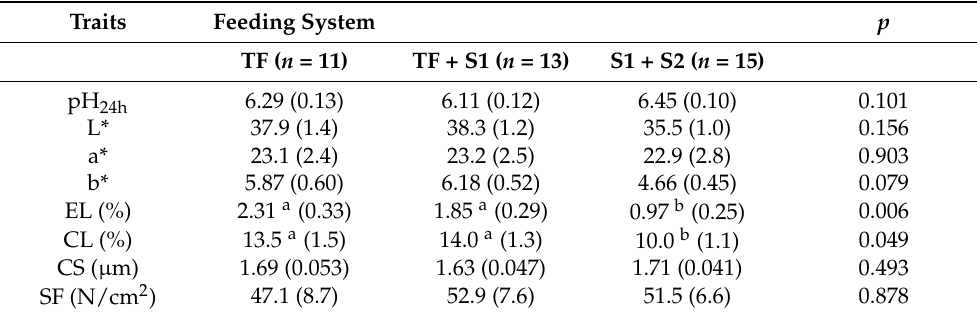
Table 4. Least square means and standard errors (in parenthesis) for meat quality traits for steers from TF, TF+S1, and S1+S2 feeding systems (Experiment 1).